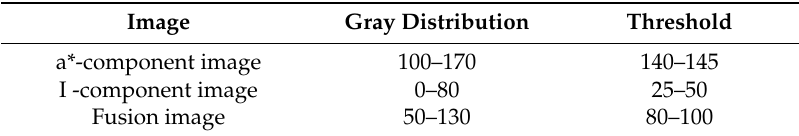
Table 2. Values of the different thresholds processed by I-component image, a*-component image and fusion image.